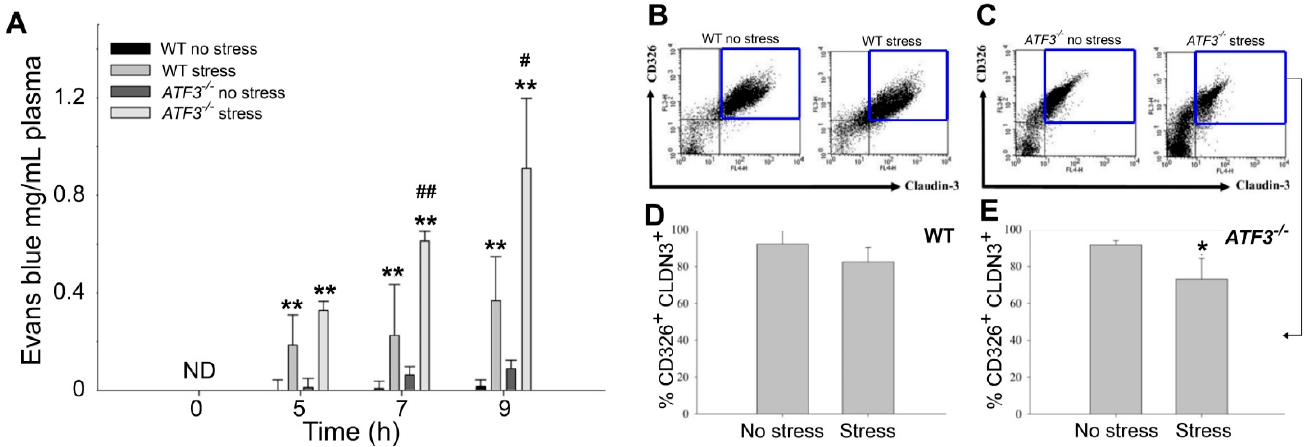
Figure 5. An ATF3 deficiency exacerbates stress ‐ induced GI injuries and claudin 3 (CLDN3) suppression. ( A ) Plasma Evans blue levels of WT (WT) and ATF3 gene knockout (KO; ATF3 − / − ) mice with or without stress at 0, 5, 7, and 9 h. ( B , C ) Flow cytometry analysis of tight junction protein CLDN3 expressing gut epithelial (CD326 + /CLDN3 + double positive) cells in WT ( B ) and ATF3 − / − ( C ) mice. ( D , E ) The quantitative results of flow cytometry CD326 + /CLDN3 + populations in WT ( D ) and ATF3 − / − ( E ) mice are indicated. ( A ) # p < 0.05 and ## p < 0.01 vs. their respective WT groups and ( A – E ) * p < 0.05, ** p < 0.01 vs. no stress groups; error bars show the standard deviation. ( A ) n = 6 (3 experiments with a total of 6 mice per group) and ( B – E ) n = 4 (2 experiments with a total of 4 mice per group).